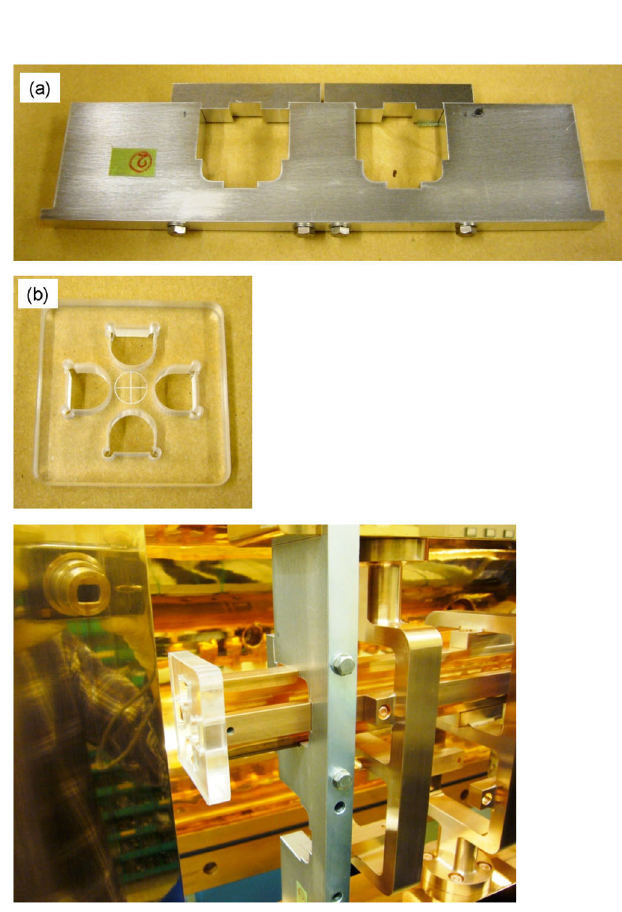
FIG. 22. (a) Jig for the rod installation and (b) target for the beam axis alignment.